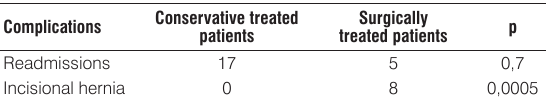
Table 2. Total number of readmission and incisional hernia due to diverticulitis.